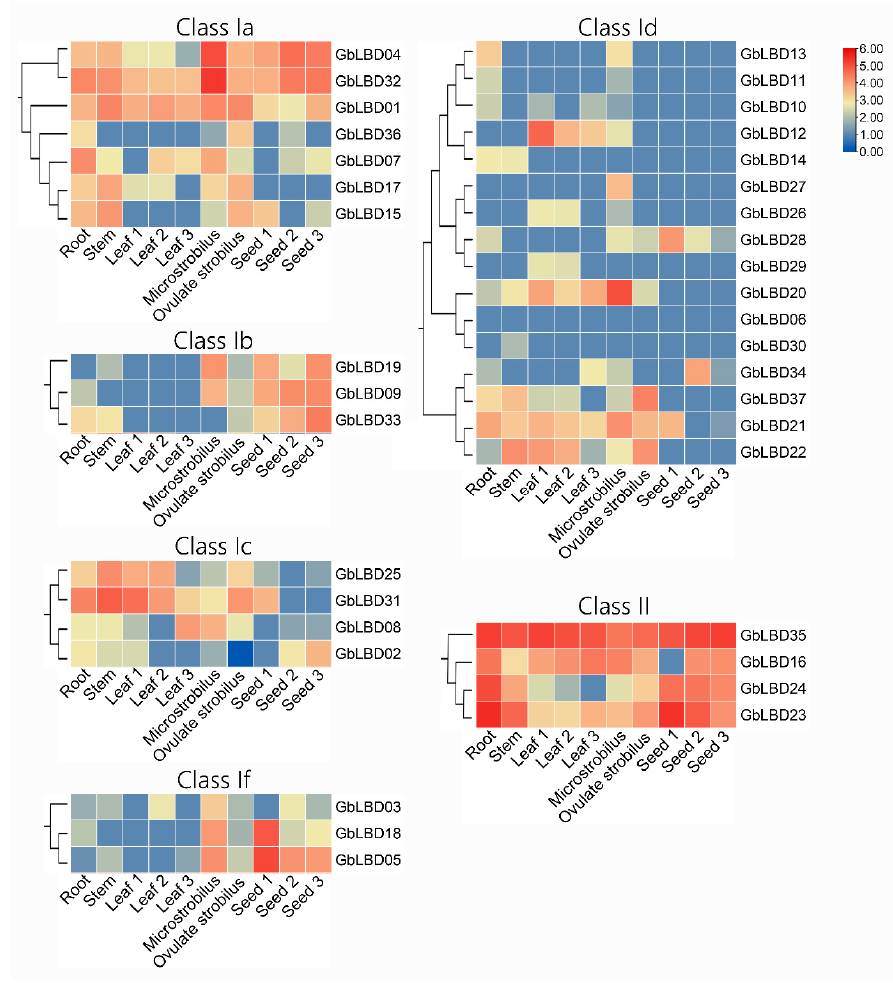
Figure 7. Heatmap of the expression of 37 GbLBD genes in six different tissues from the root, stem, leaf, microstrobilus, ovulate strobilus, and seed of plants. Red indicates high expression, blue indicates low expression, and the color scale in the upper right corner indicates the TPM value normalized by log10. Note: Leaf1, Leaf2 and Leaf3 represent June, August and October leaves, respectively; seed1, seed2 and seed3 represent June, October and January seeds, respectively. TPM, Transcripts Per Kilobase of exon model per Million mapped reads.